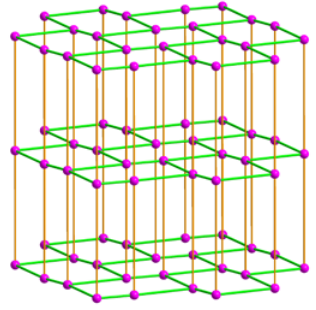
Figure 2. Schematic representation of the five-connected BN topologic network of Compound 1 ; the bpym are represented by yellow; end-on- (EO) and end-to-end- (EE) azides are represented by green; and Co are represented by purple spheres.